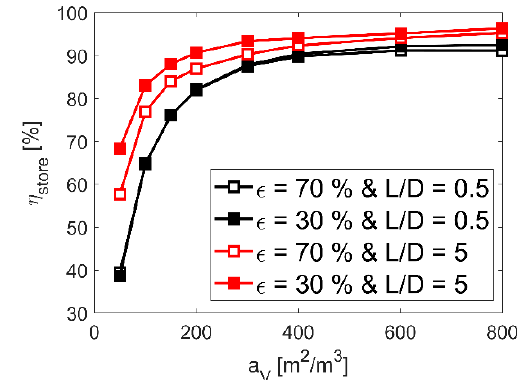
Figure 4. Storage utilization ( η store ) as a function of specific surface ( a V ), void fraction ( ε ) and length-to-diameter ratio ( L / D ) at an exemplarily selected maximum solid media storage temperature ( T PtH ) of 1000 °C.